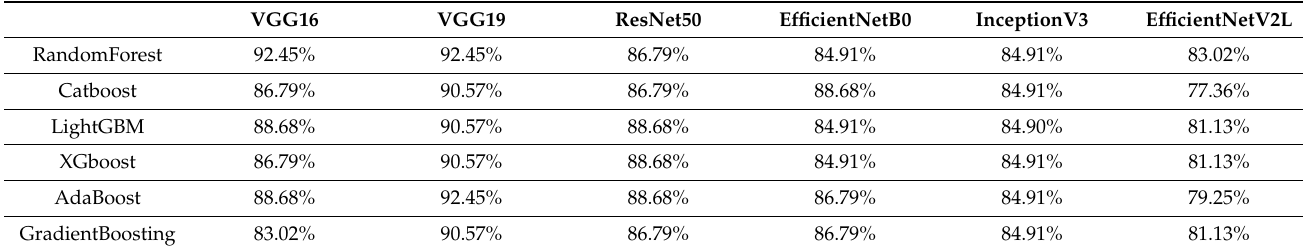
Table A5. Accuracy of each model combination for gray stars.